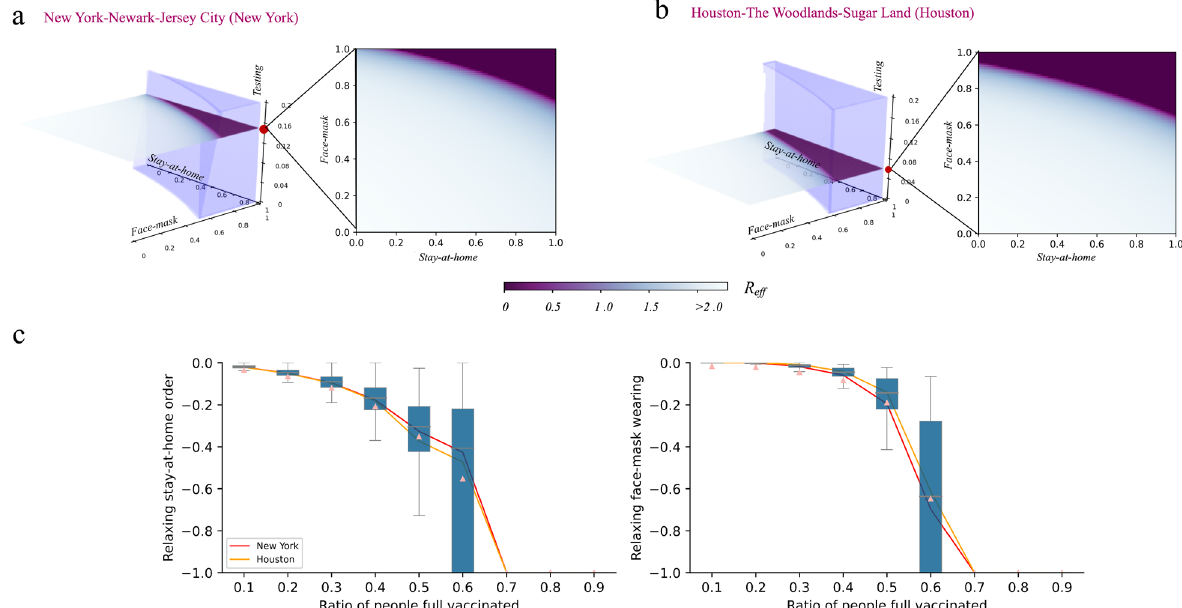
Fig. 5 Needed NPIs to keep effective reproductive ratio R e ≤ 1 with different vaccine coverage. Take the “ New York ” MSA and “ Houston ” MSA as examples; a , b show the needed magnitude for NPIs in order to keep R e ≤ 1 with zero vaccine coverage. The horizontal slices of the “ triangular prism ” are the visualization for the needed magnitude of stay-at-home order and face-mask wearing if the magnitude of testing is fi xed. c When people are fully vaccinated at different levels (vaccine coverage), how much extents of stay-at-home order and face-mask wearing could be relaxed while keeping R e = 1. The magnitude of testing is fi xed, the same as each MSA ’ s recent testing capacity. These results demonstrate relaxing interventions need thorough and careful consideration when the ratios of full vaccinated people